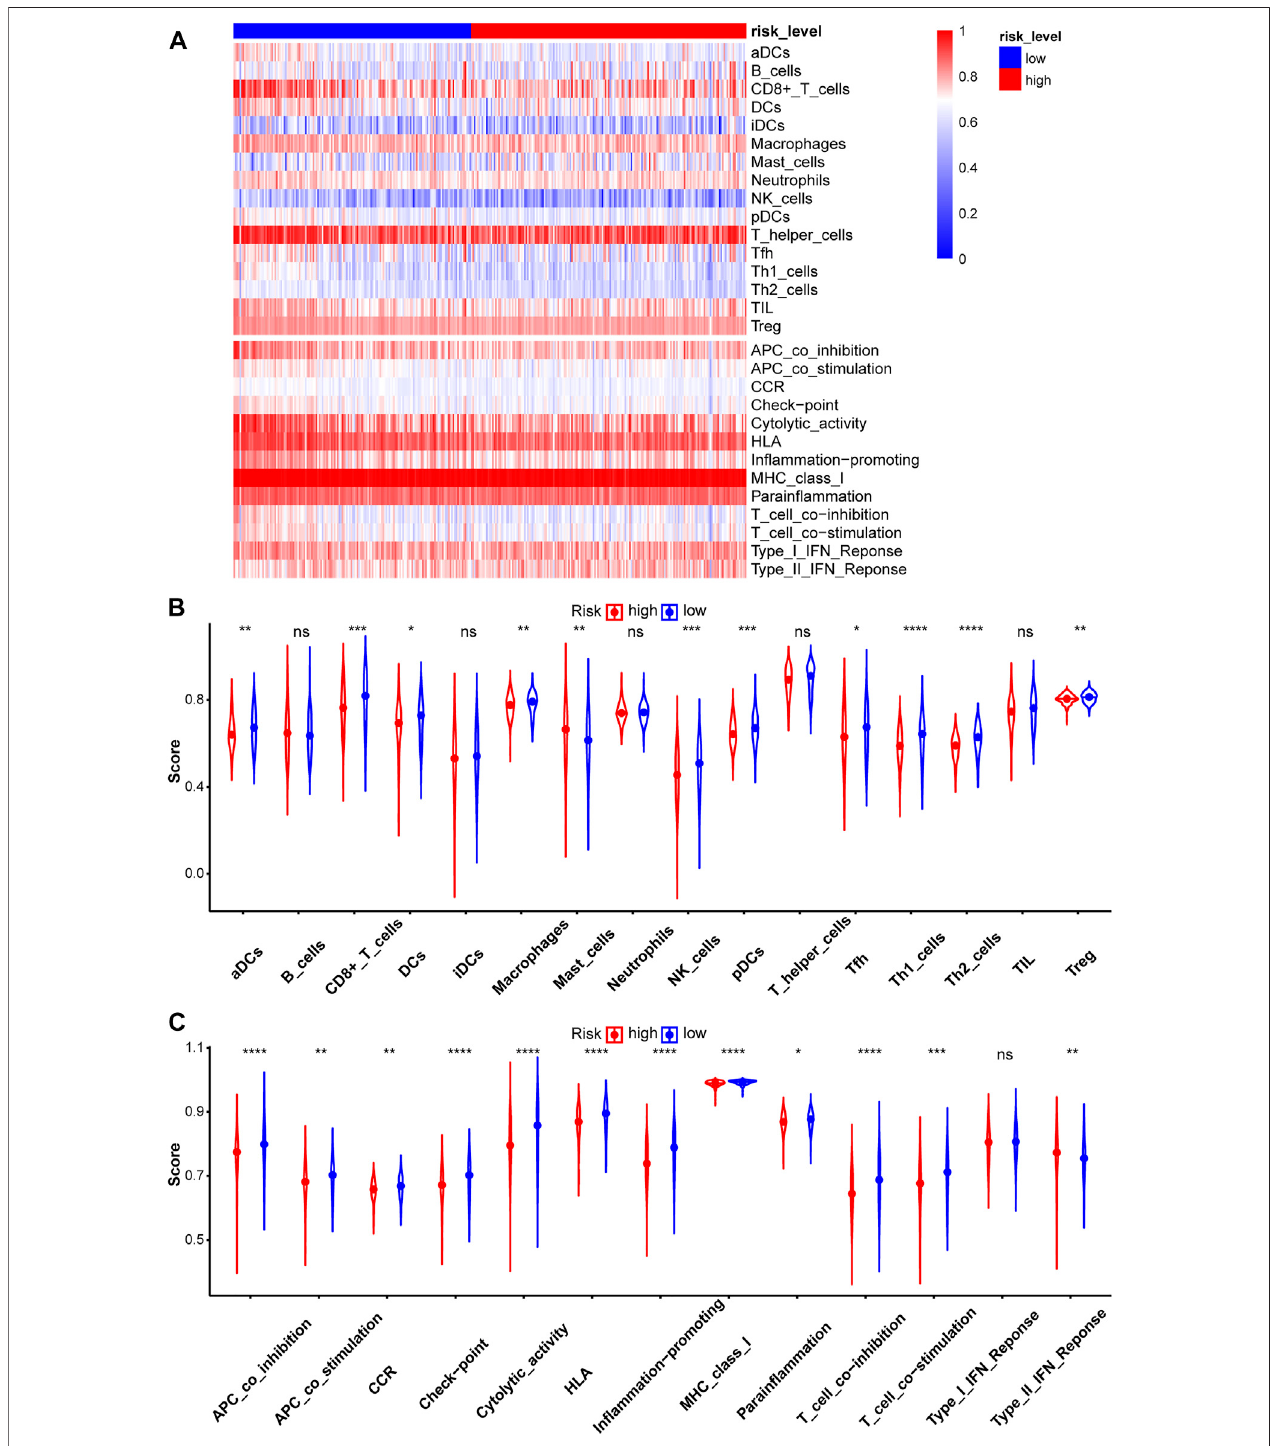
FIGURE7 | Evaluation ofImmune in fi ltration between two riskgroups inthe test2 cohort. (A) The heatmap ofssGSEA scoresin patientswith STAD was plotted to quantify the immune activity of immune cells and immune functions. The ssGSEA scores of 16 immune cells (B) and 13 immune functions (C) .